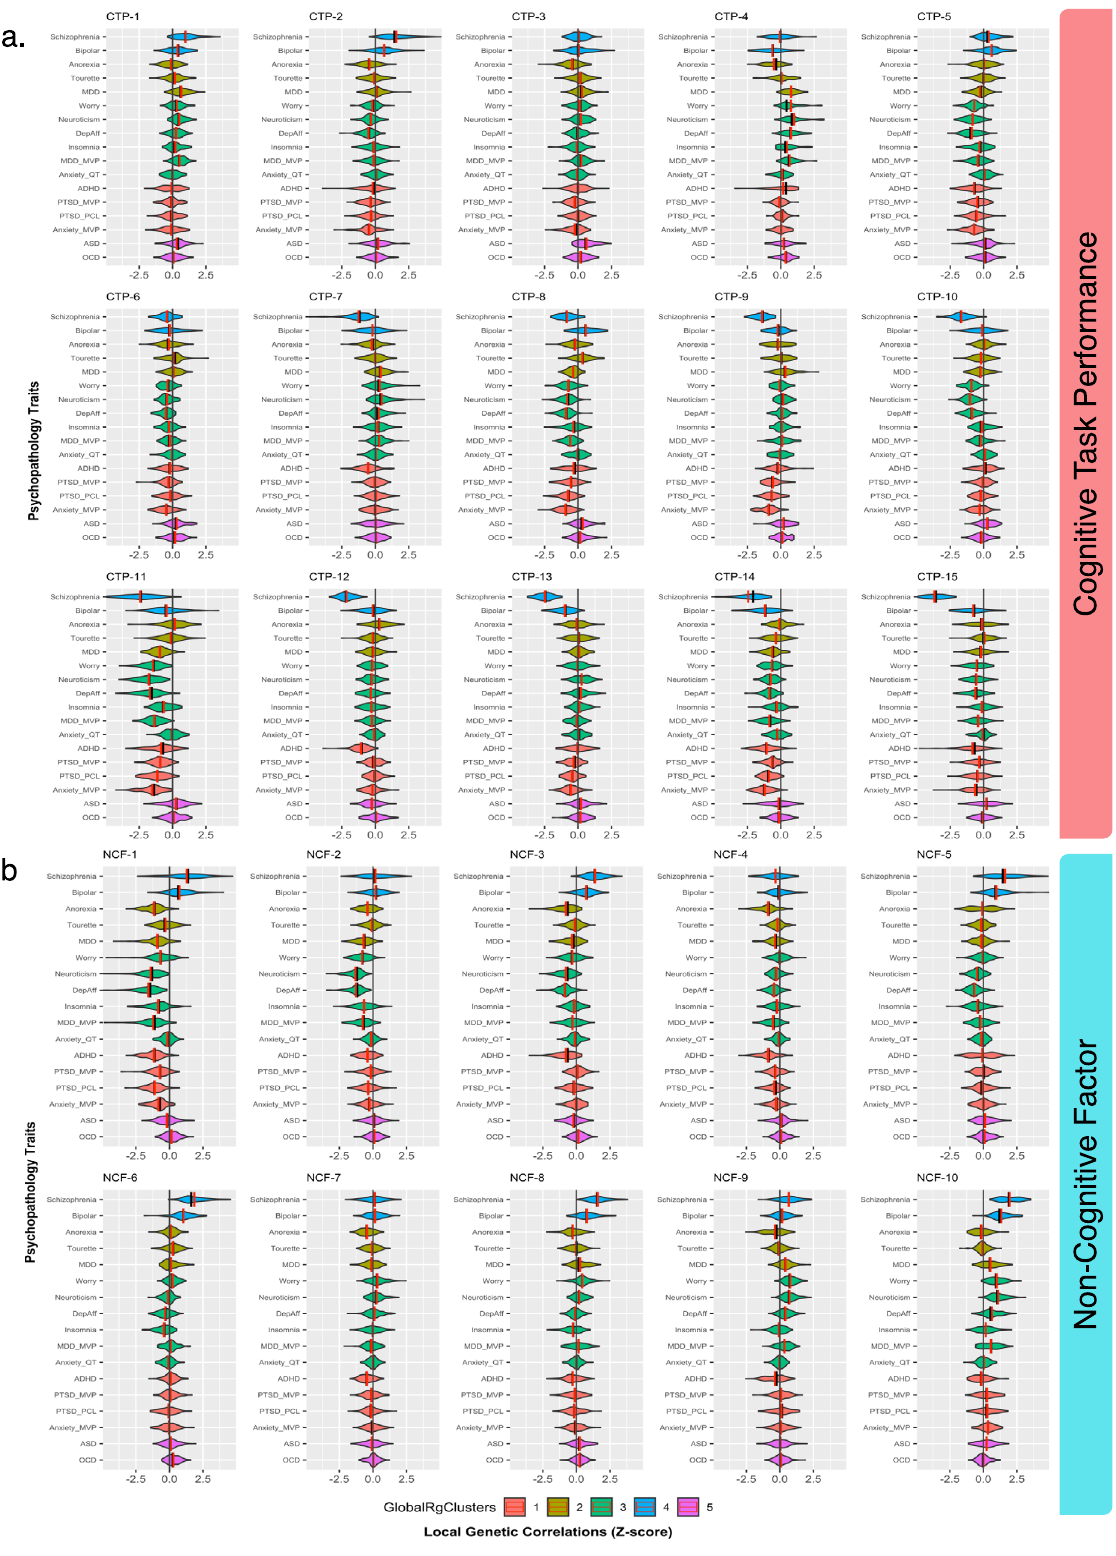
Fig.3|Violinplotsfor Z -scoredistributionsoflocalgeneticcorrelationswithin each meta-locus. GlobalRgClusters: Phenotype clusters derived from partitioned clustering ofglobalgenetic correlation.CTFcognitive taskperformance,NCFnon- cognitive factor. a Prioritized meta-loci for cognitive task performance. b Prioritized meta-loci for non-cognitive skills. a , b Bipolar: bipolar disorder,